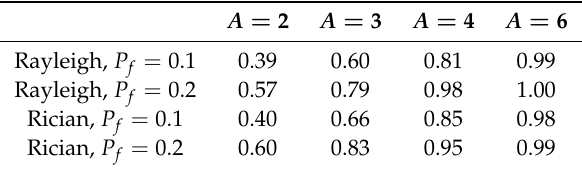
Table 5. Detection probabilities for the different numbers of antennas when the SNR = − 16 dB.